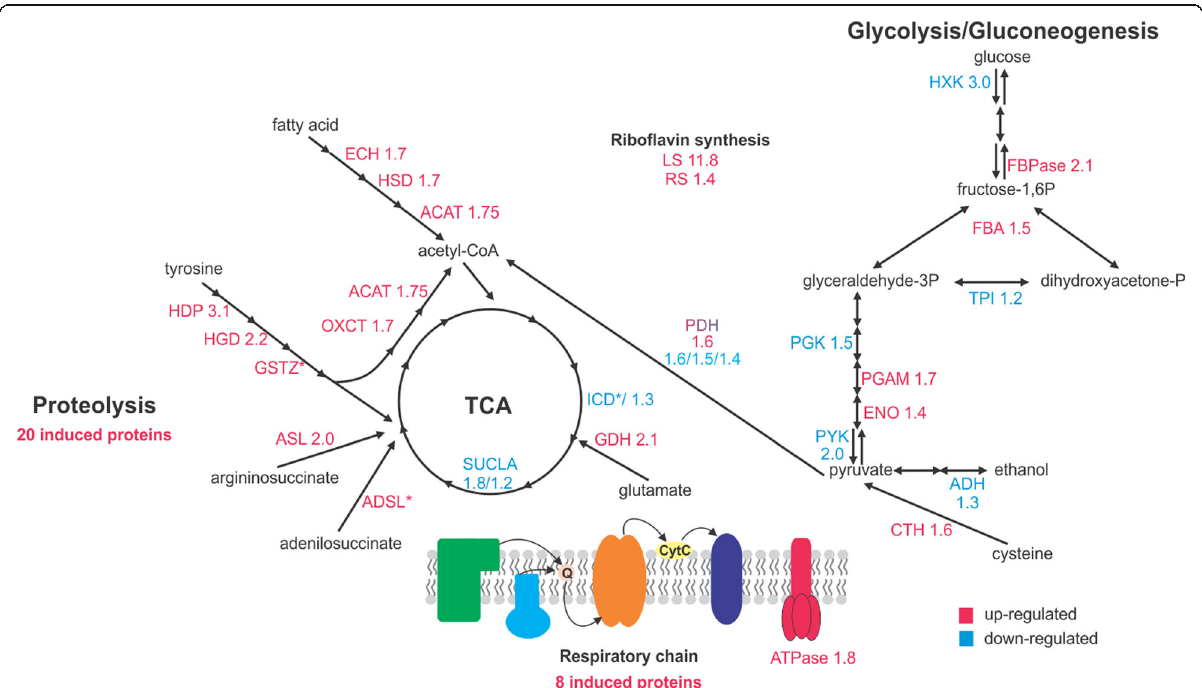
Fig. 6 Metabolic changes of P. lutzii cells grown in propionate as deduced from proteomics. HXK hexokinase; PGI glucose-6P isomerase; ALD aldolase; TPI triose phosphate isomerase; PGAM phosphoglycerate mutase; PKM pyruvate kinase; ENO enolase; ADH alcohol dehydrogenase; PDH pyruvate dehydrogenase; HGD homogentisate 1,2-dioxygenase; HDP 4-hydroxyphenylpyruvate dioxygenase; MAIA maleyl acetoacetate isomerase; SCOT succinyl coenzyme A-acetoacetyl coenzyme A-transferase; ECH enoyl-CoA hydratase; ACAT acetyl-CoA acetyltransferase; ACO aconitase, IDH isocitrate dehydrogenase; KGD 2-oxoglutarate dehydrogenase; SDH succinate dehydrogenase; MDH malate dehydrogenase; FUM fumarate hydratase; ADSS adenylosuccinate synthetase; ADSL adenylosuccinate lyase; CTH cystathionine gamma lyase; MSY cobalamin independent methionine synthase; ARG arginase; CLY ATP-citrate lyase; FASa fatty acid synthase α ; FASb fatty acid synthase β . The numbers indicate ratios of the induction (red) or repression (blue) of the proteins. * Enzymes detected only in glucose (blue) or propionate